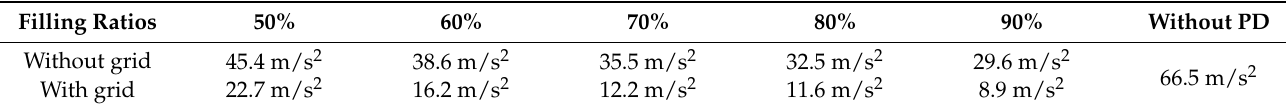
Figure 4. Vibration amplitude of cantilever beam with and without obstacle grid particle dampers at different filling ratios . different filling ratios. Table 2. Vibration acceleration response at different filling ratios. Table 2. Vibration acceleration response at different filling ratios .